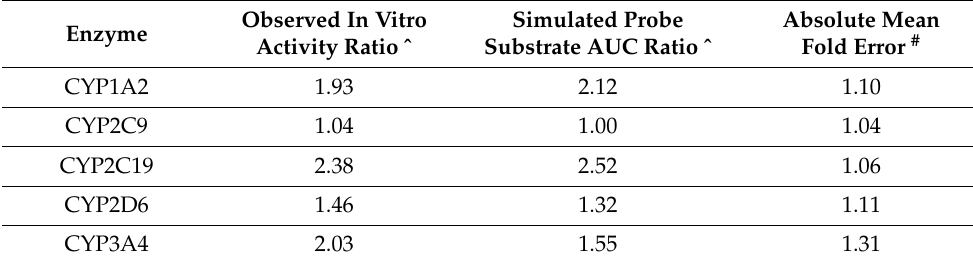
Table 3. Simulated and observed parameter ratios defining the difference in cytochrome P450 enzyme activity between MAFLD and healthy control